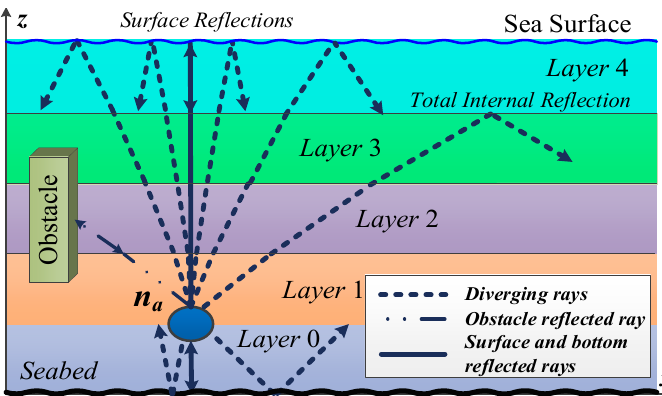
Figure 5. Conceptual 2D representation of the layered model with refraction on the edge of each layer. Only rays orthogonal to both underwater layers and sea surface/bottom as well as nearby obstacles will reflect to the node.